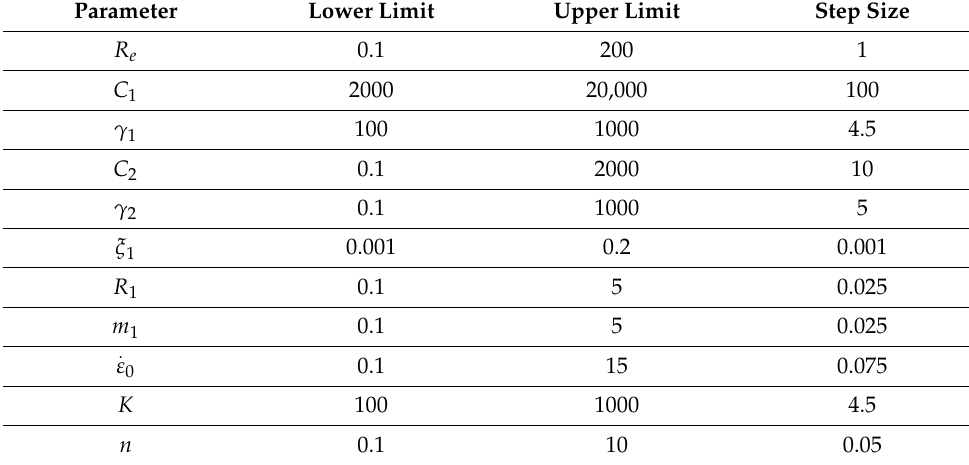
Table 1. Parameter limits and step